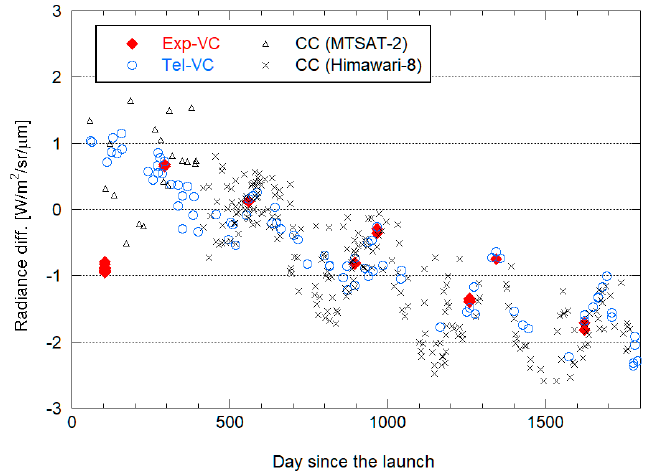
Figure 14. Difference between the ground testing-based radiance ( R 0 ) and the predicted radiance for ALOS-2/CIRC as a function of the day since the launch ( D ).